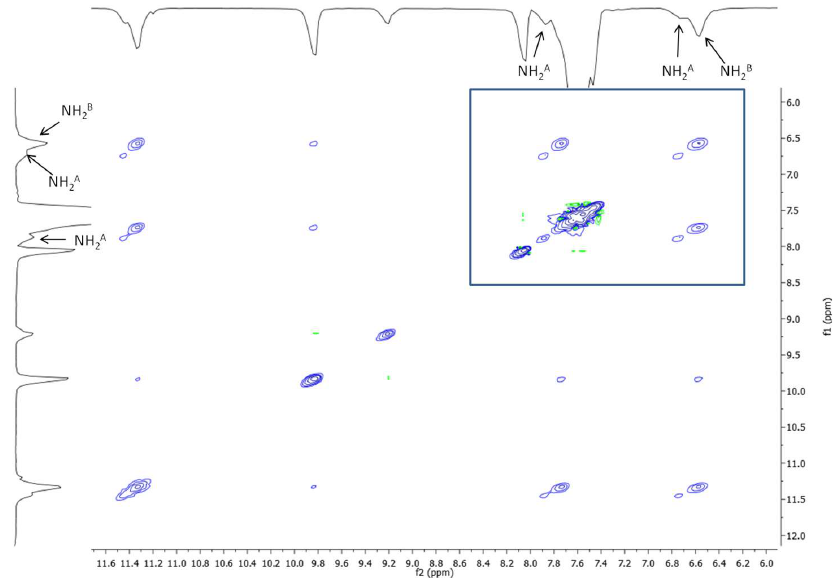
Figure 5. EXSY cross-correlation in DMSO- d 6 suggesting a low rotational barrier of the C sp2 –N bond in amide 8a and 8e . Cross-correlations for the amino groups of conformer A and conformer B were found at 6.76 and 7.89 ppm, and at 6.58 and 7.58 ppm, respectively.